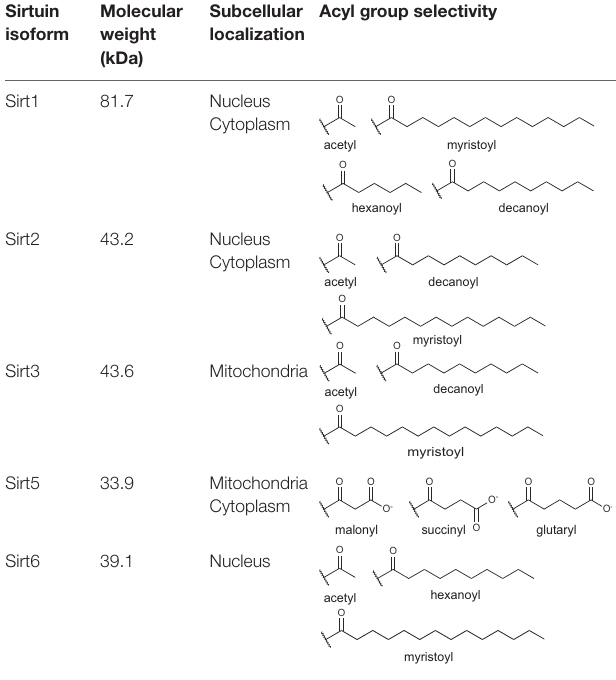
TABLE 1 | Human sirtuin isoform molecular weight, subcellular localization, and known lysine deacylase targets. Sirtuin Molecular Subcellular Acyl group isoform weight localization (kDa)